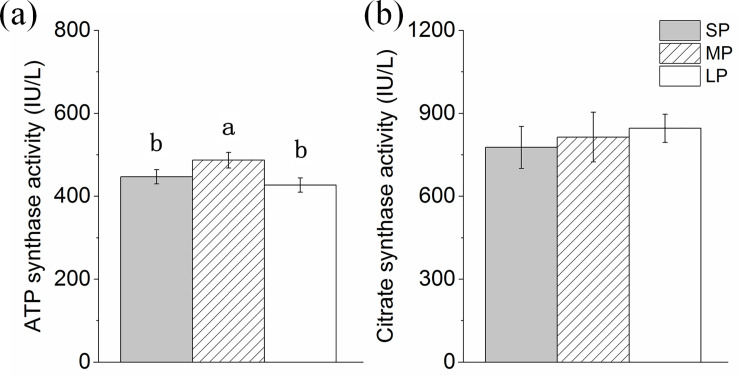
ATP synthase (a) and citrate synthase (b) activity in HG of hamsters in three different photoperiodic groups. Values are means ± SD. n = 10. SP, short photoperiod; MP, moderate photoperiod; LP, long photoperiod. Different letters identify statistically significant difference (P < 0.05).